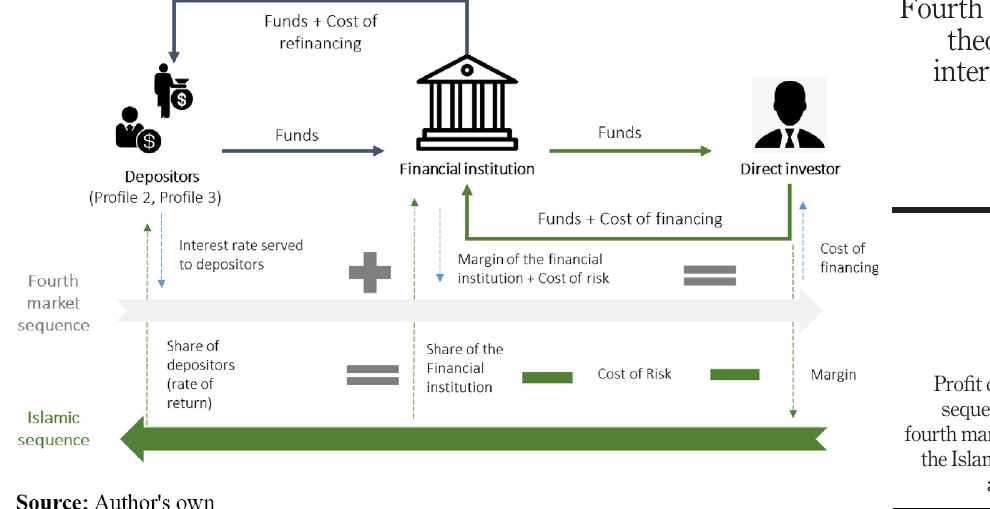
Figure 5. Pro fi t calculation